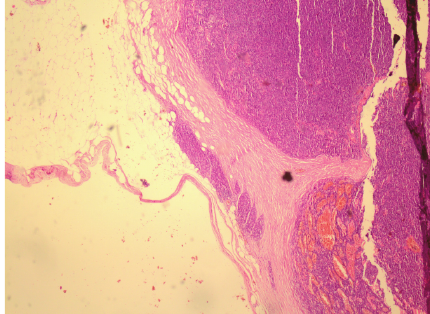
Figure 1: Microscopic view of first patient’s sample. It shows prominent epithelial component that is consistent with B 3 type WHO classification 2004 (H&E stain × 200).